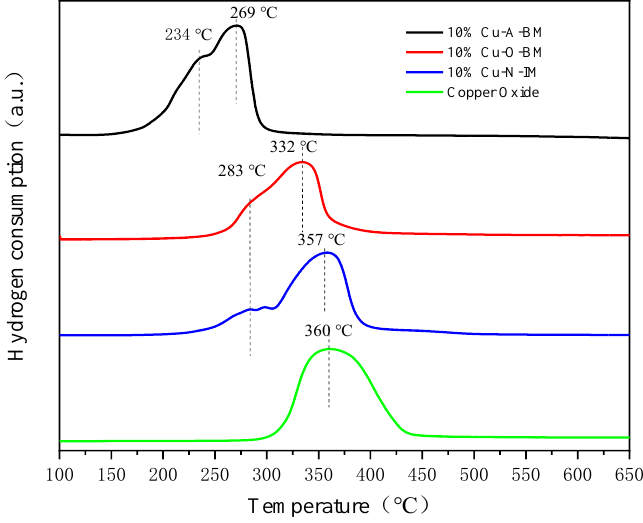
Figure 6. TPR profiles of CuO/SiO 2 catalysts prepared from different precursors and methods.